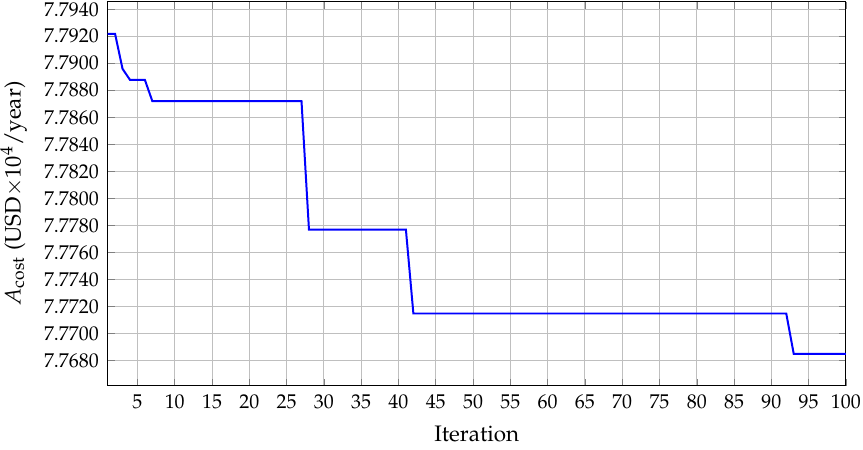
Figure 6. Convergence curve of the IEEE 33-node with a meshed